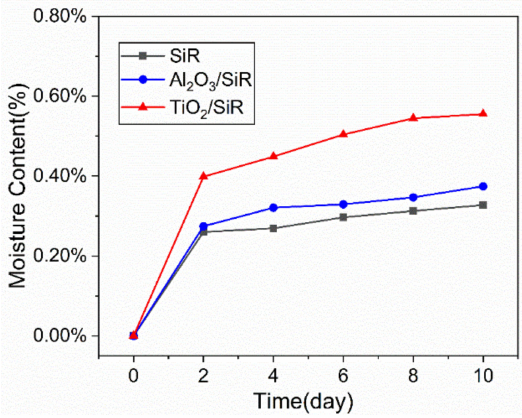
Figure 2. Moisture content of different